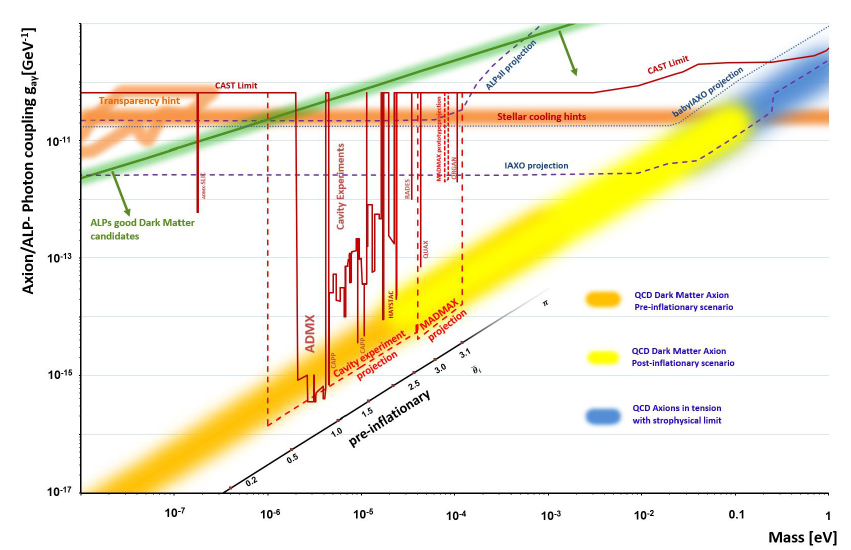
Figure 6. Plot of the axion / ALP to photon coupling vs. mass. Limits are indicated as solid lines, projections as dashed lines. Astrophysical limits are also shown as shaded areas in orange. The diagonal gives the range compatible with KSVZ and DFSZ